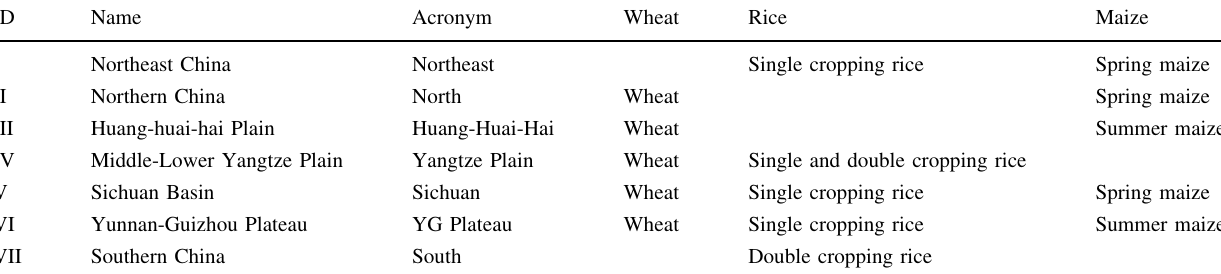
Table 1 Agricultural zones in China